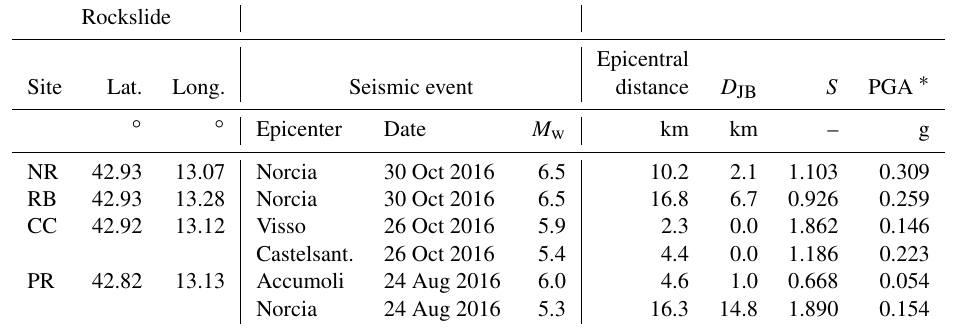
Table 4. Parameters of the triggering events utilized to calculate the motion at the rockslide sites from the available recorded accelerograms. Rockslide Epicentral Site Lat. Long. Seismic event distance D JB S PGA ∗ ◦ ◦ Epicenter Date M w km km – g NR 42.93 13.07 Norcia